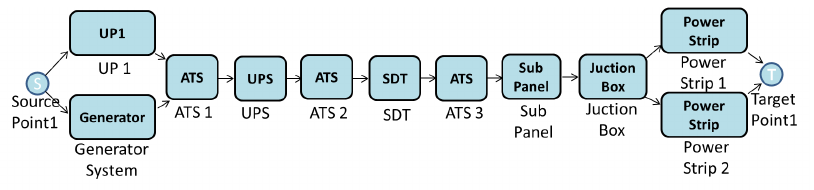
Figure 14. EFM model of Tier I.